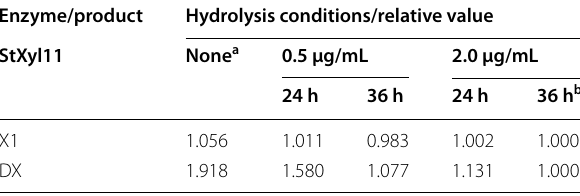
Table 2 Hydrolysis of DX by the successive reaction with StXyl10 and StXyl11